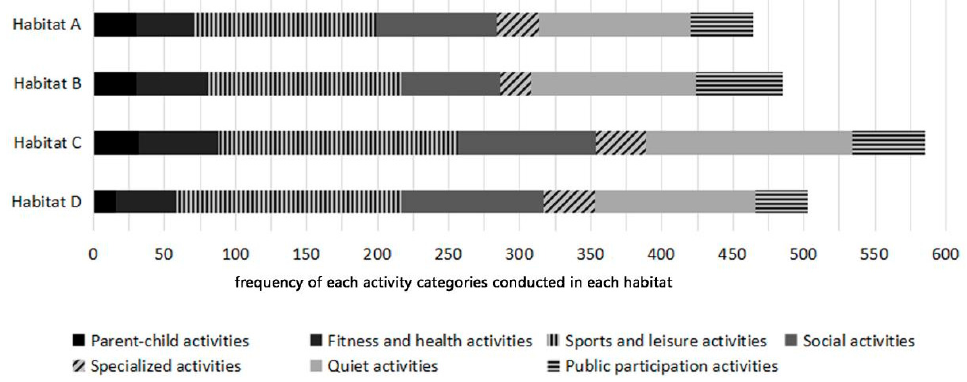
Figure 4. Frequency of various activity categories respondents engaged in the four habitats.